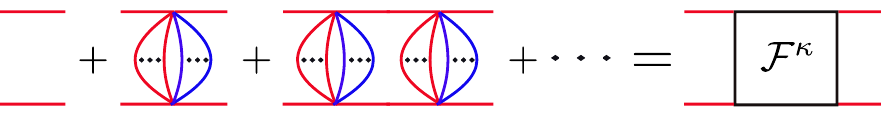
Figure 4 . Simplest \melonic" contribution to (cid:20) propagator in large N limit.